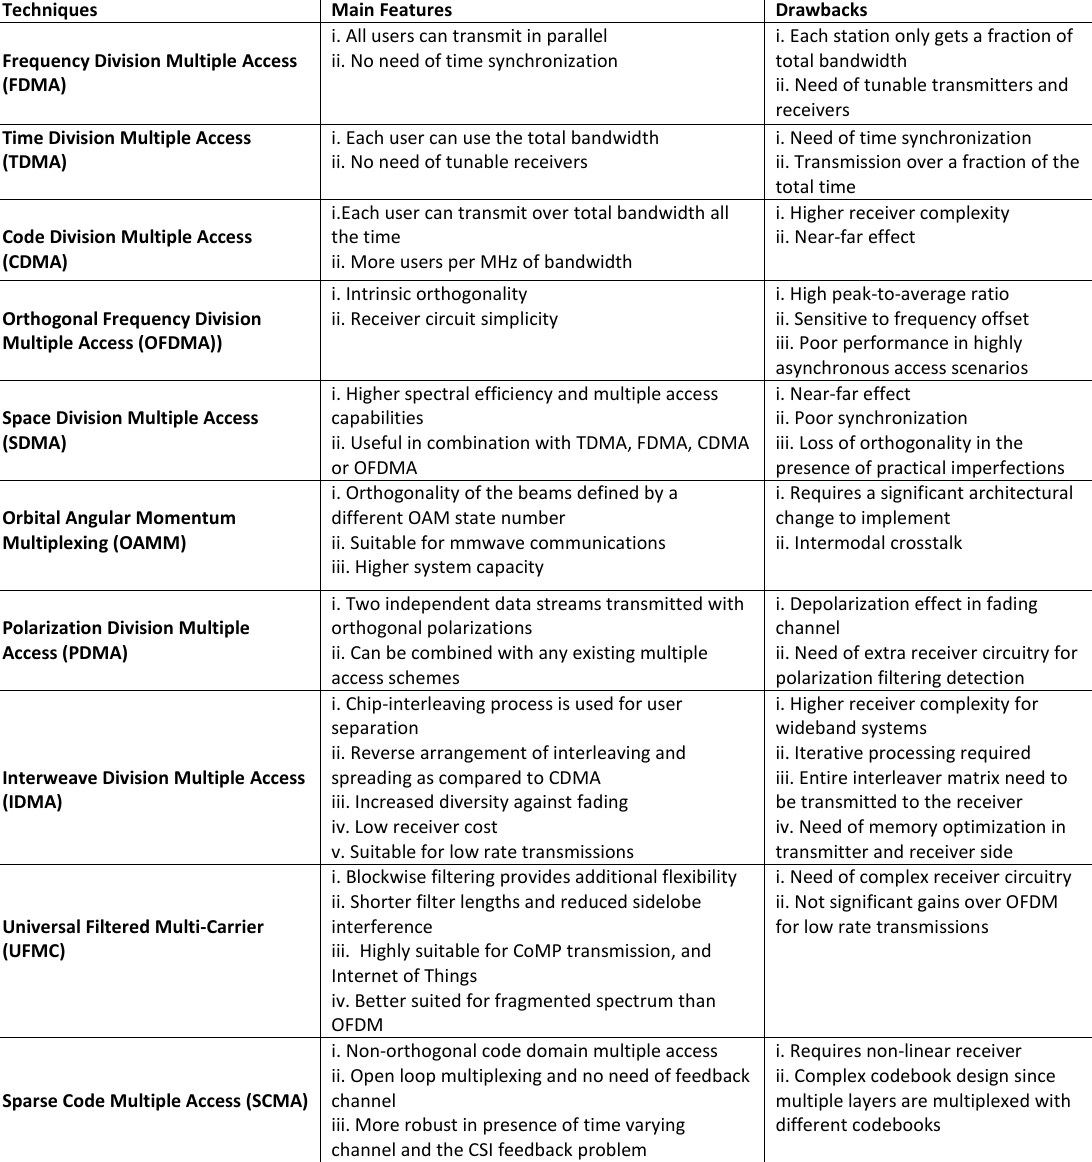
Table 2. Main Features and drawbacks of Several Existing and Emerging Multiple Access/Multiplexing